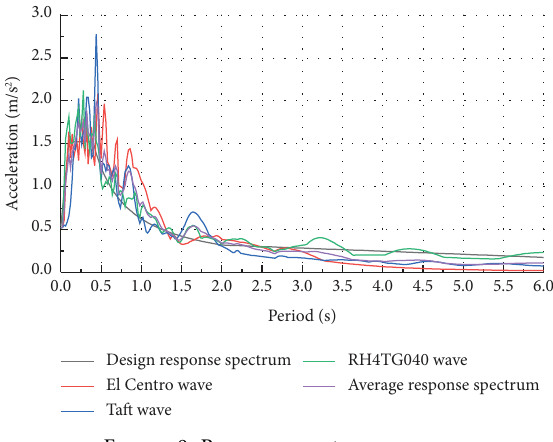
Figure 9: Response spectrum